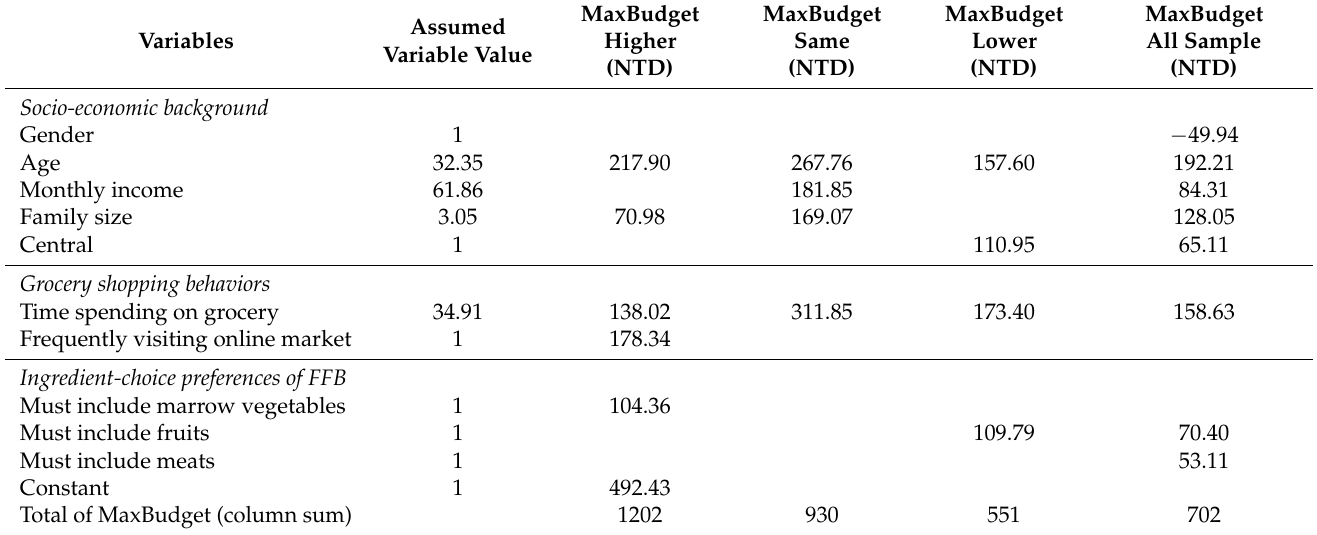
Table 3. The Elicitation of Maximum Budget for Each